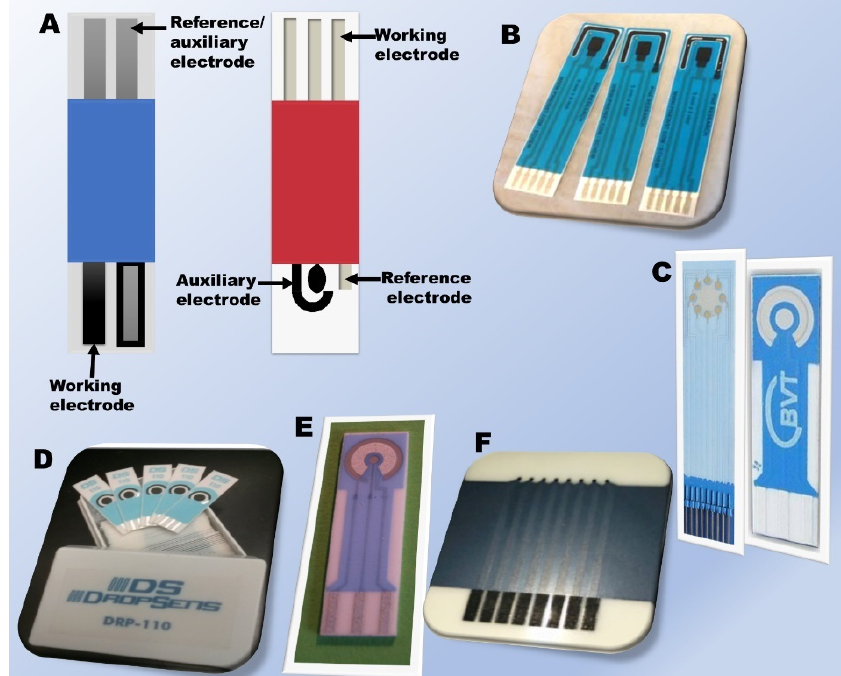
Figure 10. Screen-printed electrodes that are commercially available. ( A ) schematic diagram of generation one (left) and two (right) SPEs. ( B ) SPE from Pine Research including a carbon working electrode, a carbon counter electrode, and an Ag/AgCl reference electrode [133]. ( C ) left—AC9C Sensor array with graphite working electrode and Ag/AgCl reference electrode, right—AC1 Sensor with graphite working and auxiliary electrodes and Ag/AgCl Reference Electrode from BASi [135]. ( D ) metrohm SPE based on carbon, gold, platinum, silver, or carbon nanotube inks [132]. ( E ) PalmSens electrodes with same material working and counter electrodes (C, Pot, Ag, Au or Au-Pt alloy) and reference electrode made from Ag or Ag/AgCl [134] and ( F ) SPCE from Kanichi Research Services Ltd. housing eight working electrodes [136].